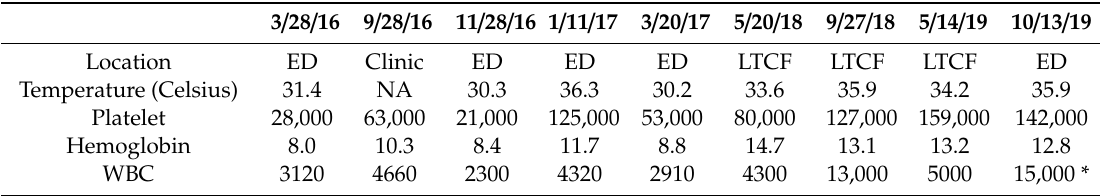
Table 1. Case 1 temperatures and blood cell counts.